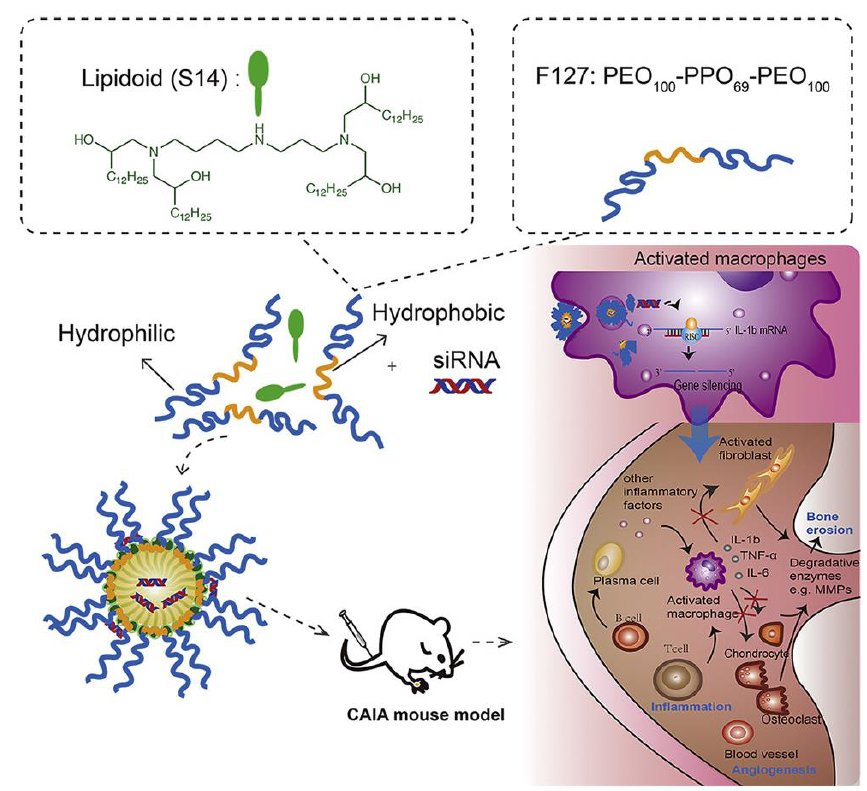
Figure 1. Schematic preparation and mechanism of lipidoid-polymer hybrid nanoparticles with anti-inflammatory effects. Reprinted with permission from Ref. [21]. Copyright © 2019 The American Society of Gene and Cell Therapy.